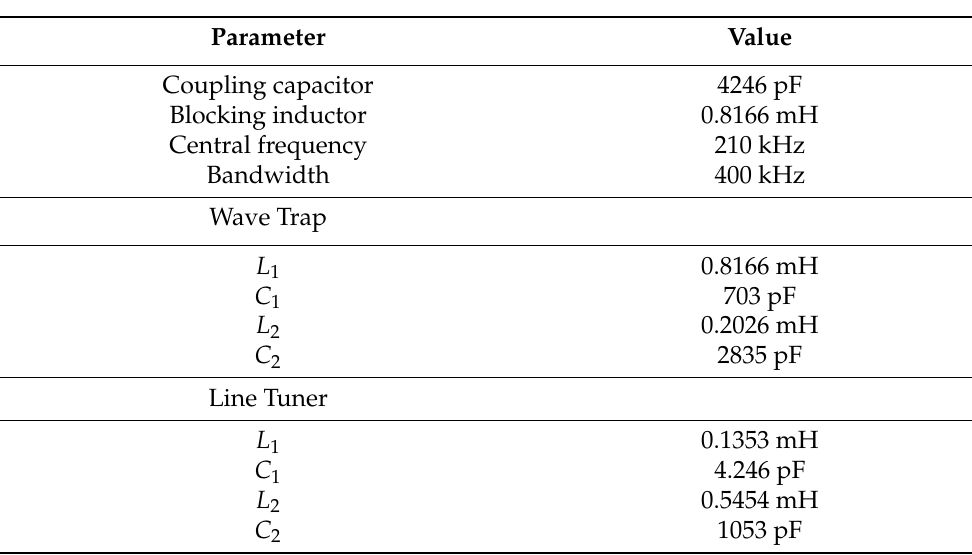
Table 2. Coupling